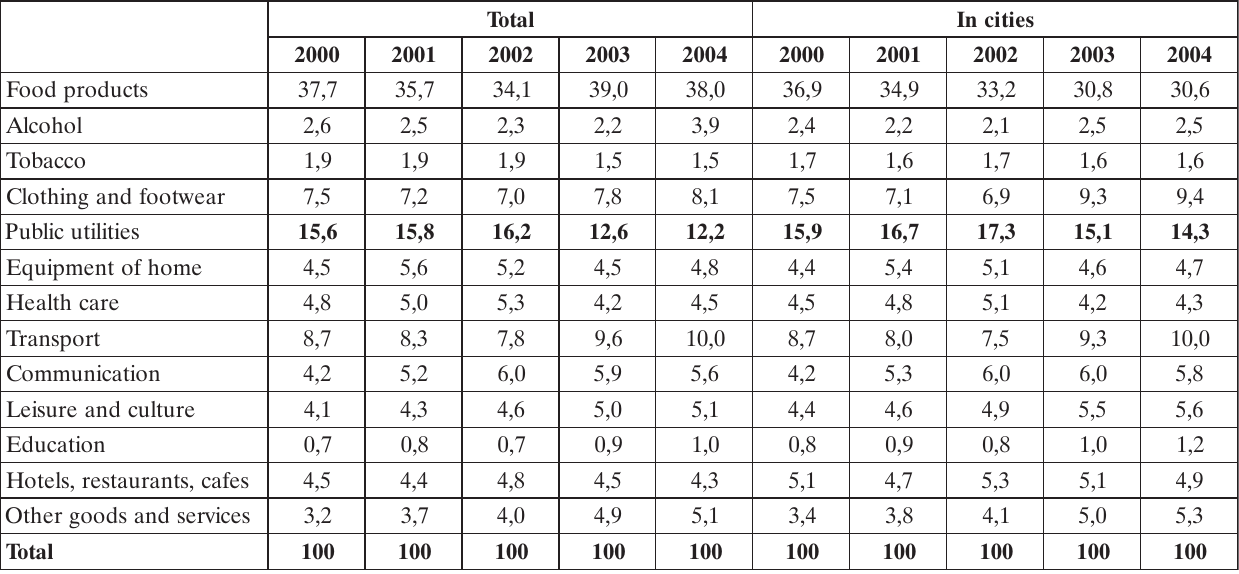
Table 4. Structure of household expenditure in Lithuania,